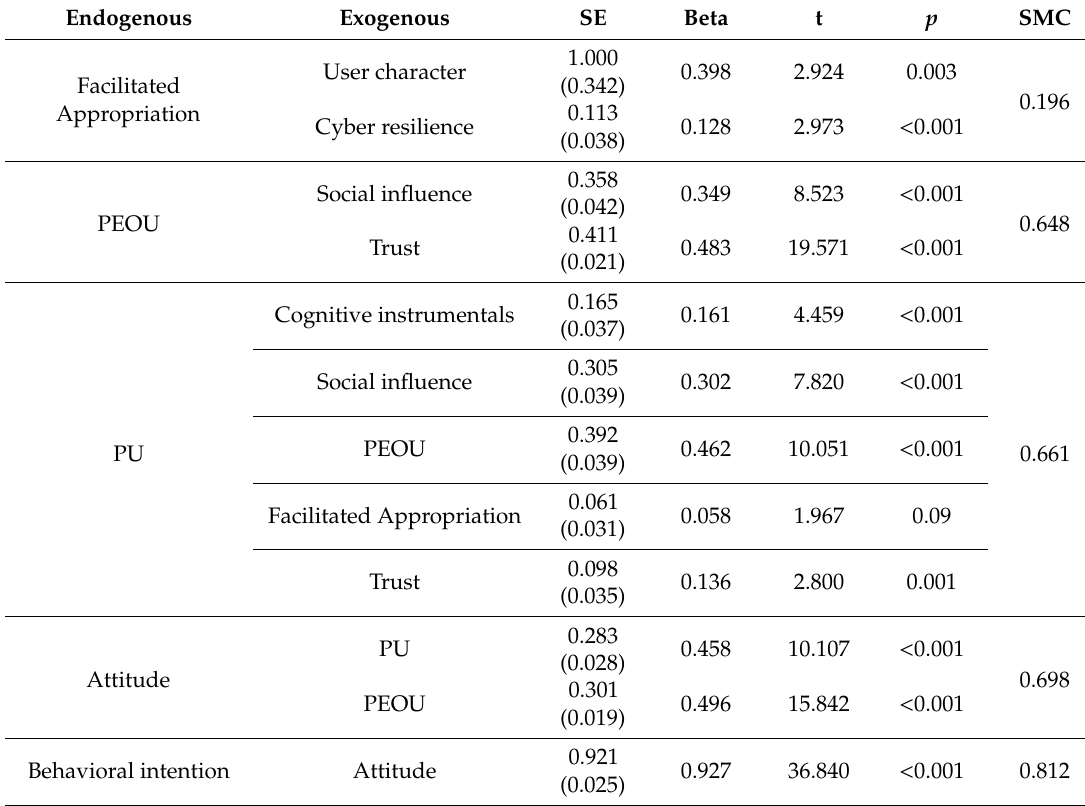
Table 5. Standardized estimates of IoT acceptance model.